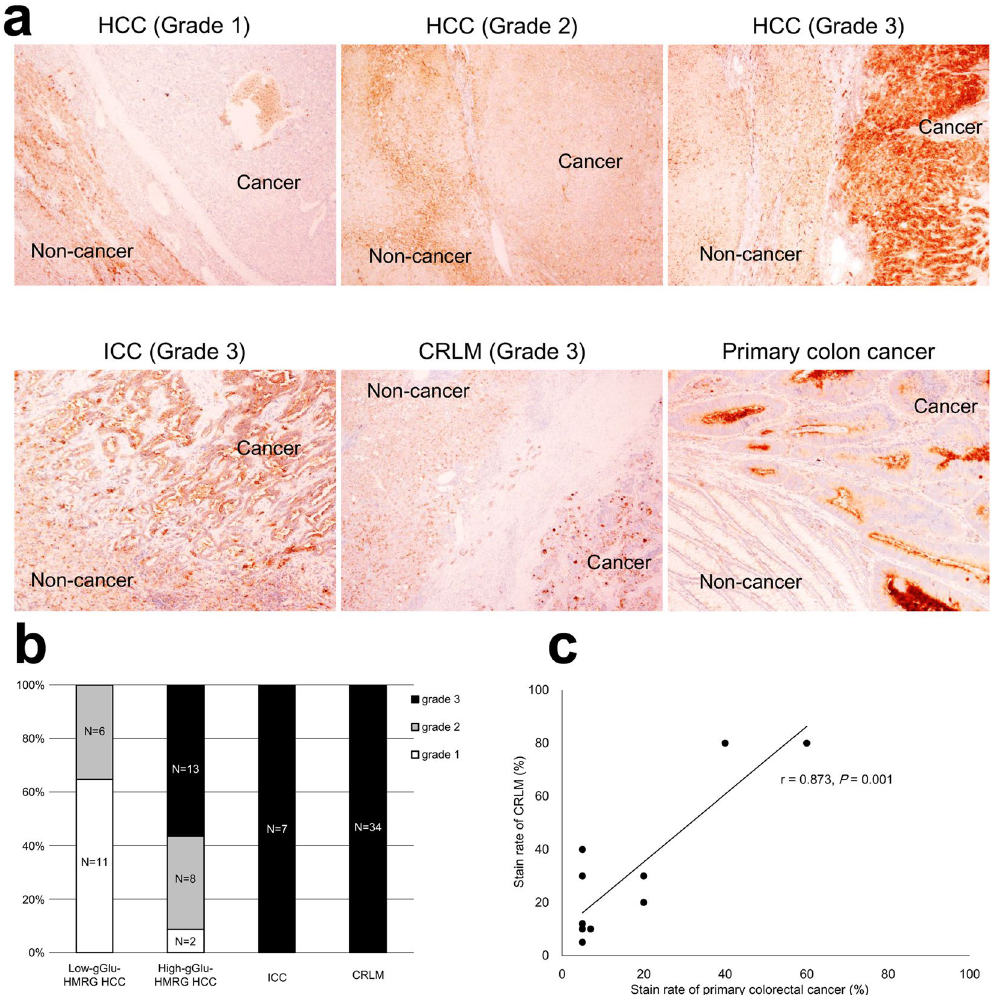
Figure 5. GGT expression in resected tissues. ( a ) Immunohistochemical staining of GGT in tissue samples showing the grades assigned according to the cell membrane staining pattern: Grades 1, 2, and 3 correspond to lower, equivalent, or higher, respectively, staining intensity in cancerous tissues compared with non-cancerous liver parenchyma. ( b ) Proportion of the indicated tumor samples with GGT staining Grades 1, 2, and 3. Staining intensity tended to be higher in 23 High-gGlu-HMRG HCCs (21 samples Grade 2 or 3) than in 17 Low-gGlu- HMRG HCCs (6 samples Grade 2 or 3, P < 0.001). All 7 ICCs and 34 CRLMs examined were classified as Grade 3. ( c ) In 9 patients (10 metastatic tumors) with synchronous CRLM, the “stain rate” (proportion of cancerous tissue stained vs. unstained) in the hepatic metastases were positively correlated with and tended to be higher than the stain rates of the corresponding primary colorectal cancers (Pearson’s correlation coefficient r = 0.873, y = 1.28 × + 9.76, P =